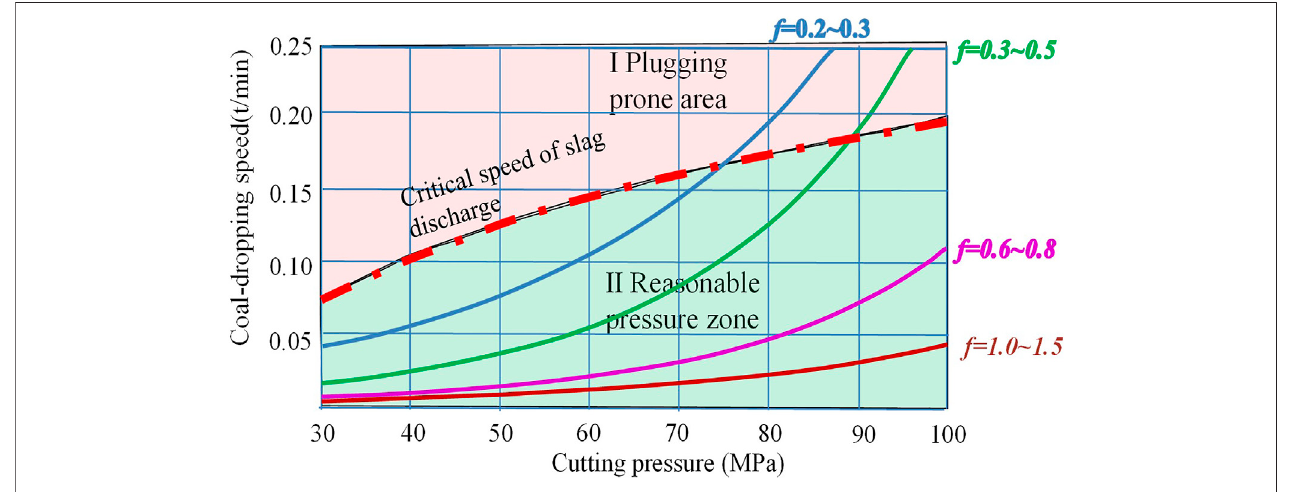
FIGURE 7 | Model for the coordinated slag disposal during the